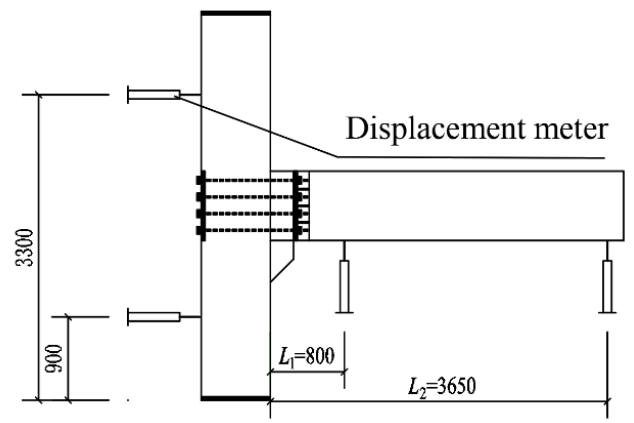
Figure 9. Strain gauge arrangement of the test piece reinforcement.